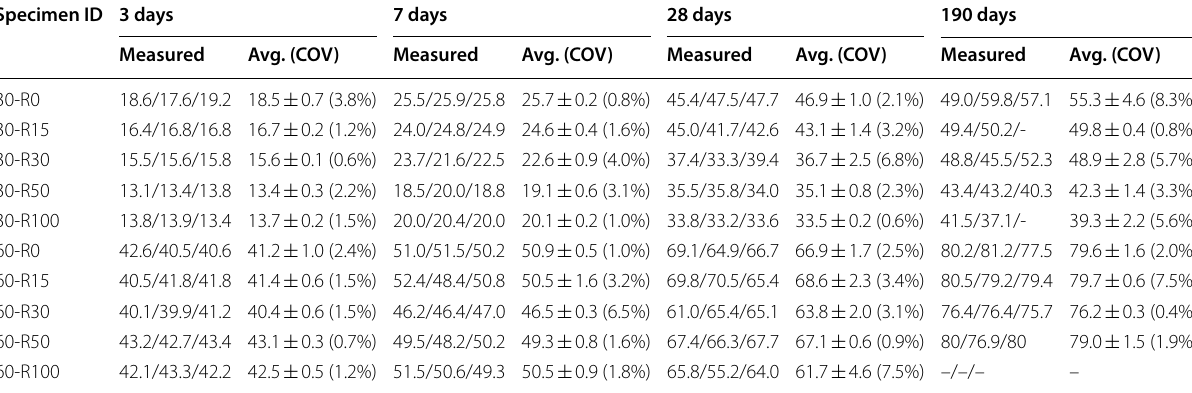
Table 6 Compressive strength results (Unit: MPa). Specimen ID 3 days